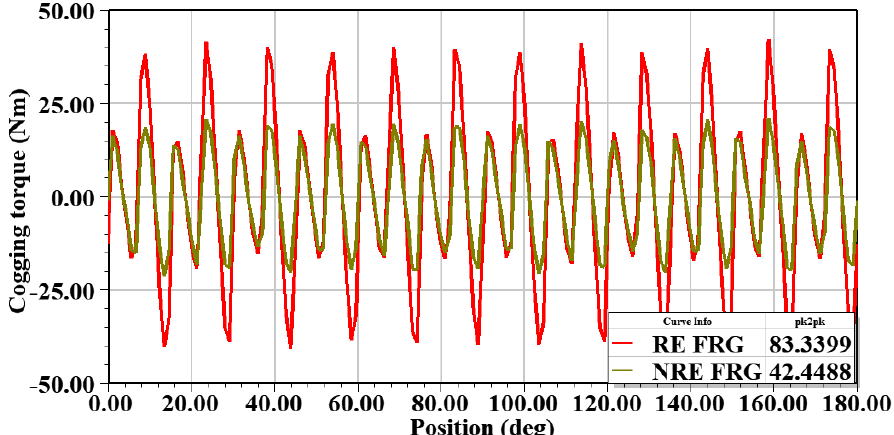
Figure 5. Cogging torque comparison under no-load.